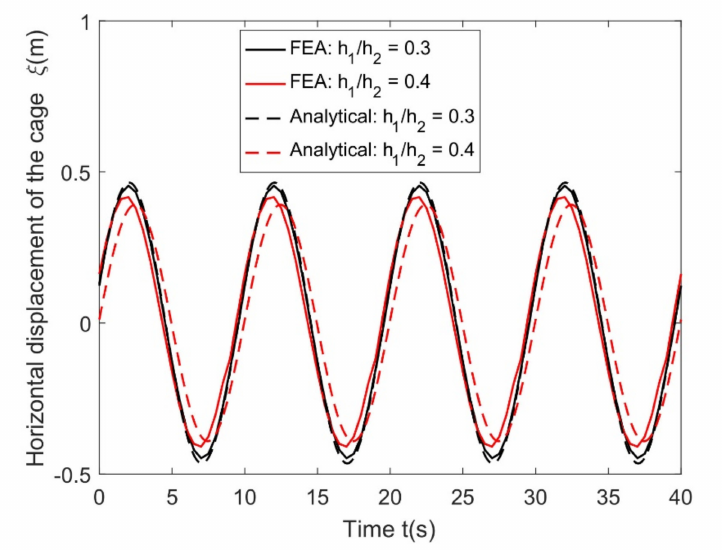
Figure 3. Comparison of the horizontal displacement of the cylindrical flexible net cage for a different cage height h 1 between the numerical FEA and analytical simulations for h 2 = 50 m, a = 3 m, and k s = 10 3 Nm − 1 .